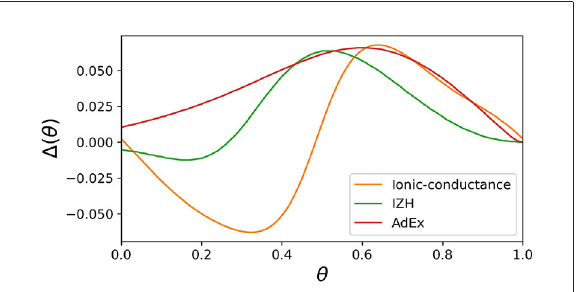
FIGURE1 Phase-resetting curve of spiking neuron models. The horizontal axis represents the phase at which the pulse stimulus was given, and the vertical axis represents how much the phase was shifted by the pulse